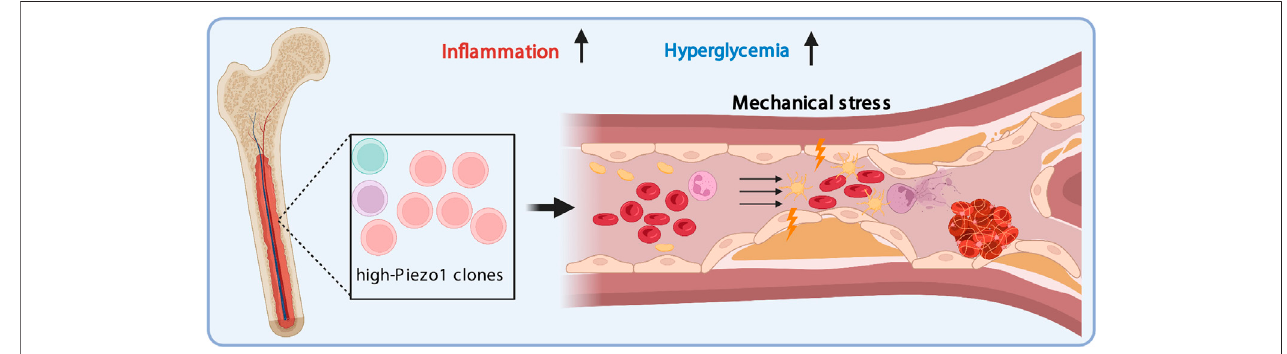
FIGURE 1 | Cell competition related to PIEZO1 during hematopoiesis. PIEZO1 expression levels lead to selection at several levels. High PIEZO1 expressing cells have proliferative advantage at baseline which is accentuated by hyperglycemia at key stages of hematopoiesis. This advantage may be determined by genetics, epigenetics or even stochastic variation. Subsequent selection may include survival advantages in multiple other settings each of which may apply only to speci fi c cell types, but the net outcome is an associated increase in the susceptibility to thrombosis in a signi fi cant proportion of diabetic patients. Detecting such variation requires single cell phenotyping at scale.